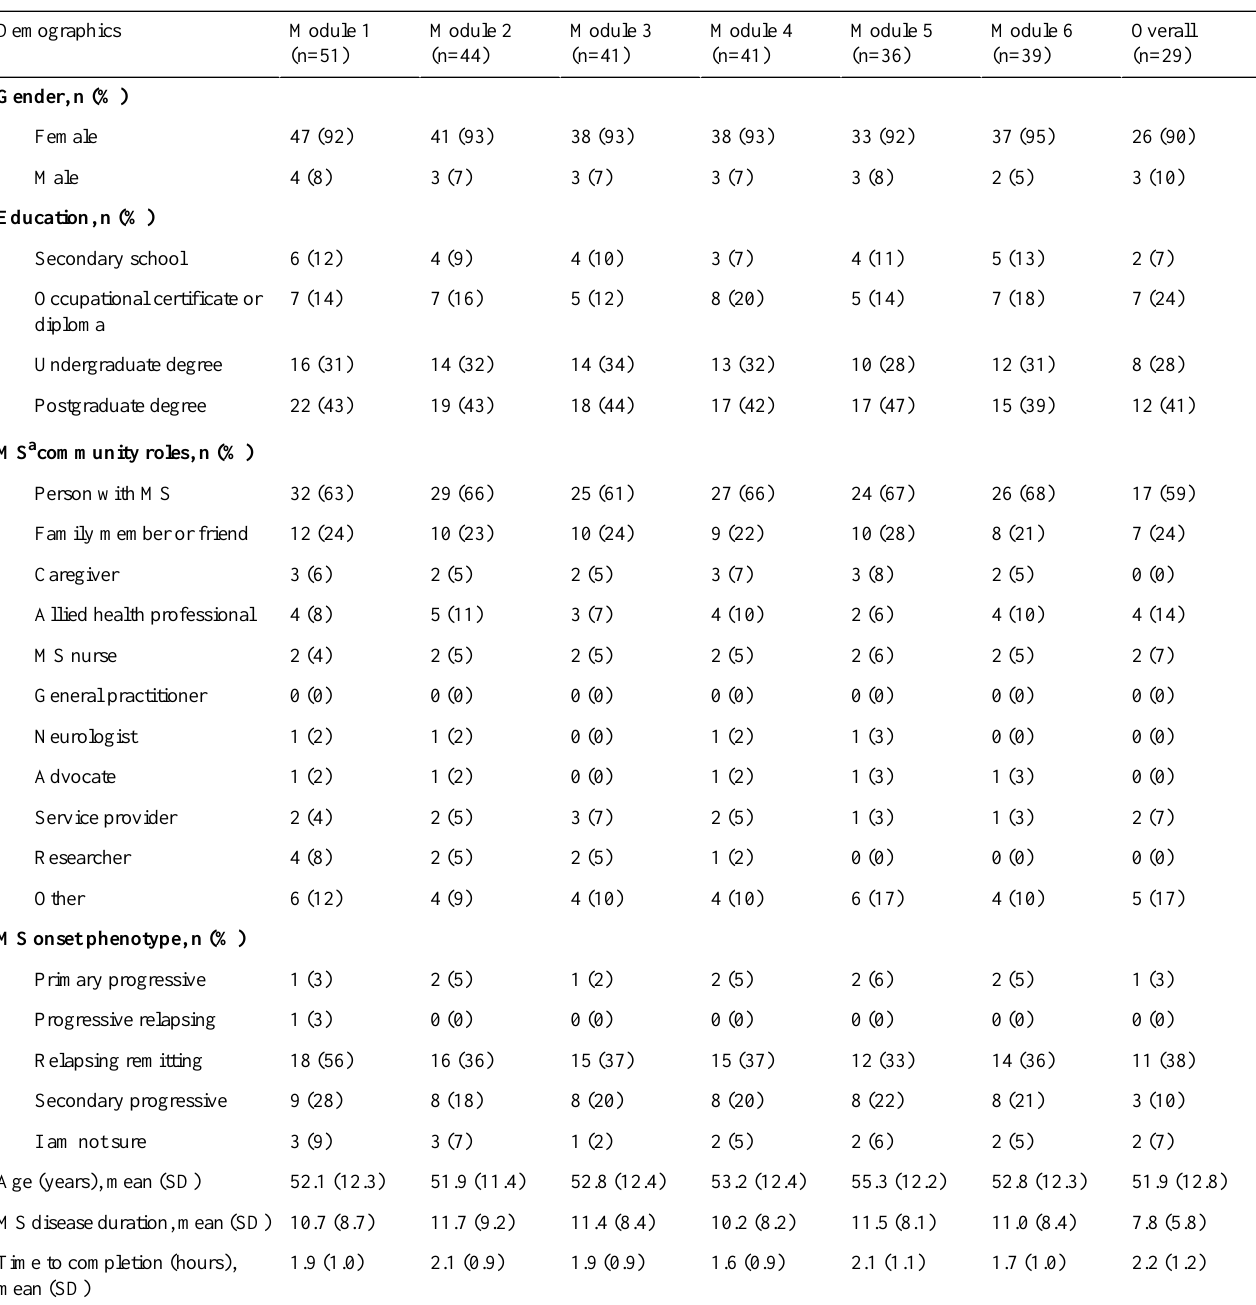
Table 3. Demographics of the pilot study participants who completed the feedback